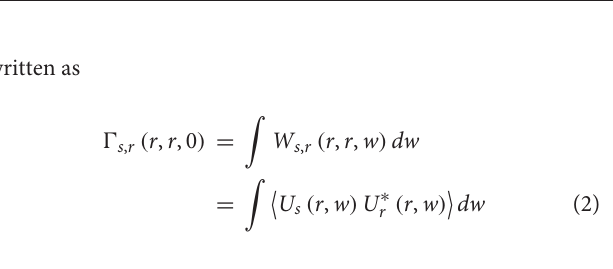
FIGURE 1 | The wDPM add-on module uses a 4-f system coupled to the output port of a bright light microscope. A camera is placed at the output of the module to record the interference intensity.